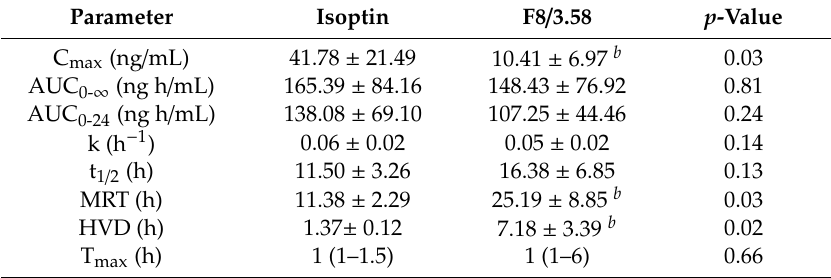
Table 4. Mean pharmacokinetic (PK) parameters of VP following oral administration of Isoptin ® and F8 / 3.58 beads to six albino